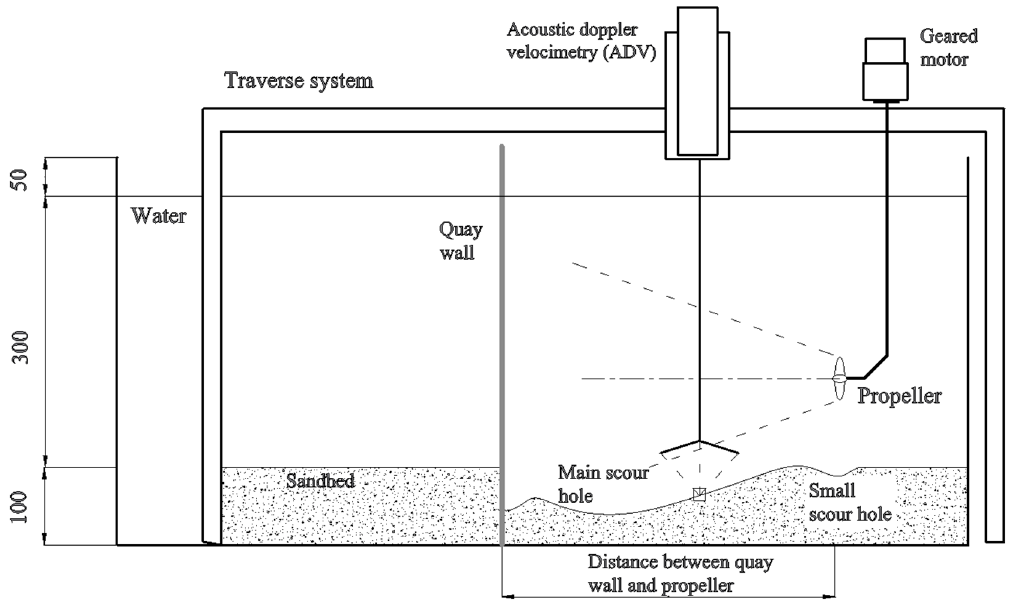
Figure 1. Experimental setup.